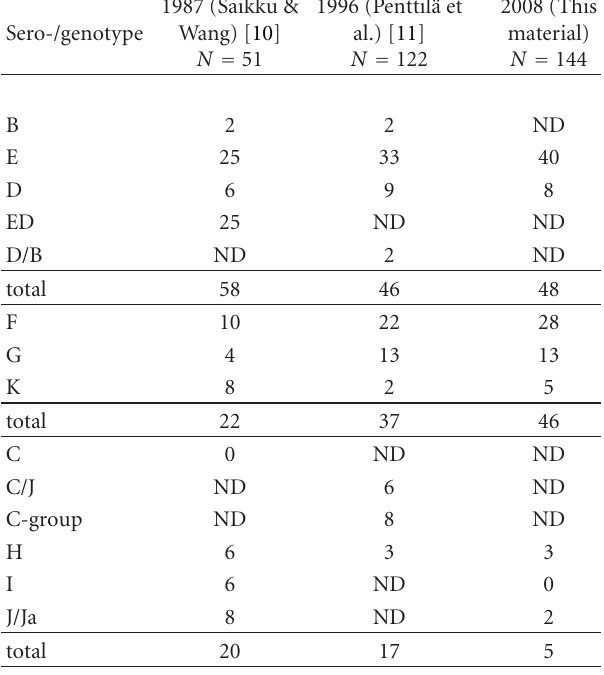
Table 1: The ompA genotype distribution (%) of 144 clinical C. trachomatis strains from this study (2008) compared with the distribution of types in isolates from the same laboratory in 1996 ( ompA PCR and restriction fragment length polymorphism, RFLP) and in 1987 (micro-immunofluorescence, MIF) in